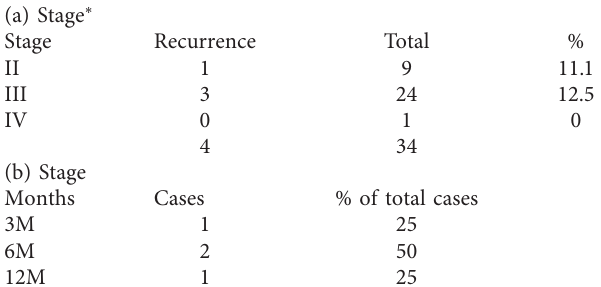
Table 4: Recurrence of POP after